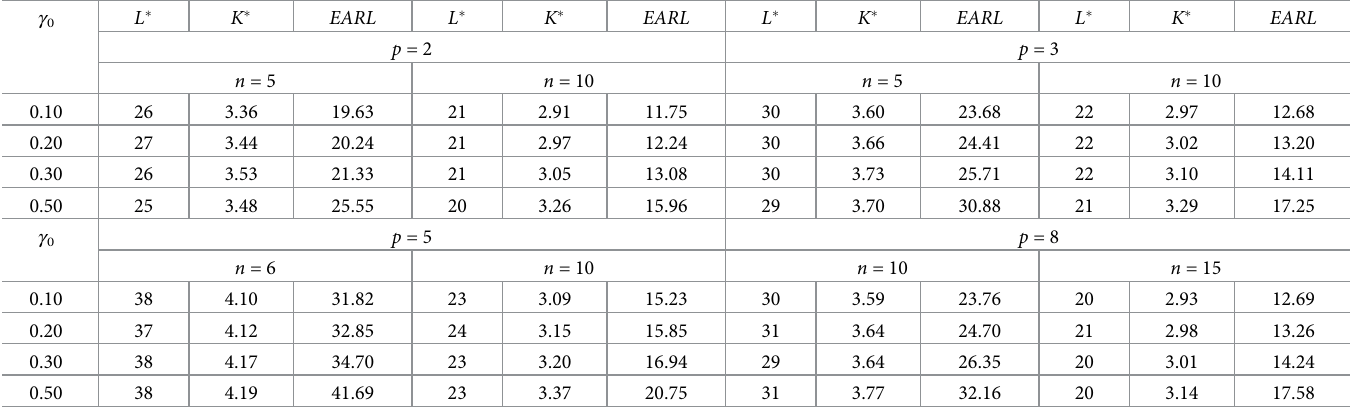
Table 4. Optimal charting parameters and the corresponding EARL values of the multivariate SS chart for p 2 {2,3,5,8}, n 2 {5,6,10,15} and γ 0 2